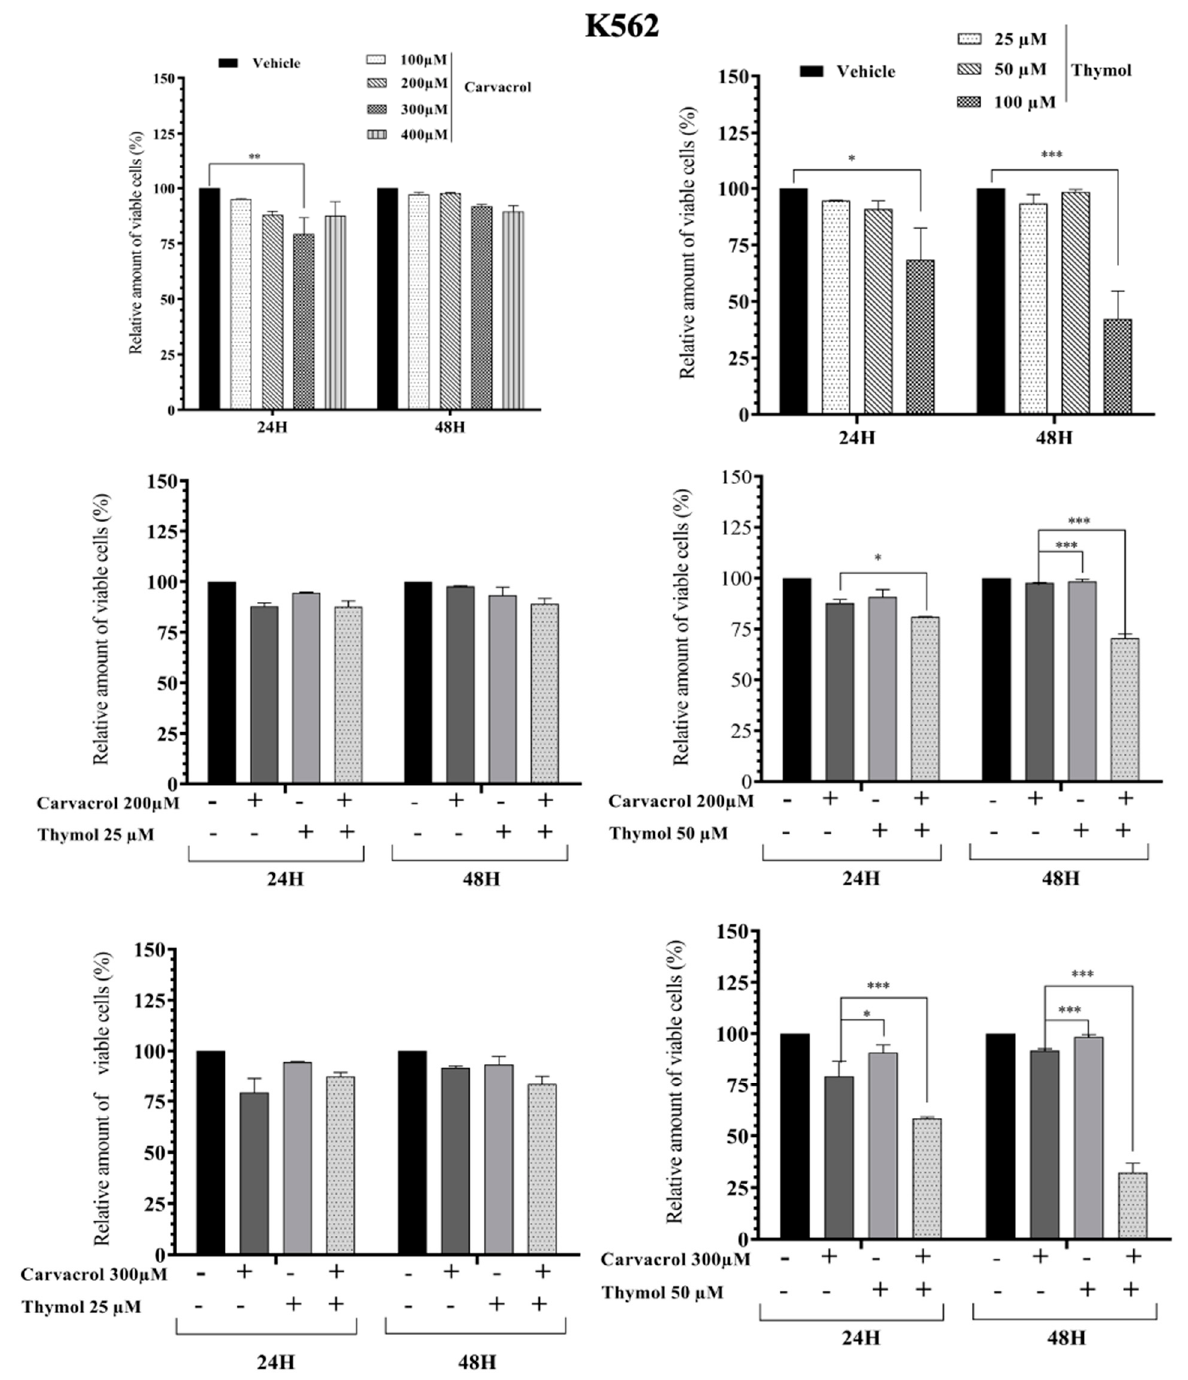
Figure 5. Impact of carvacrol, thymol, and their combination on the viability of the K562 myeloid leukemic cells. Flow cytometric analysis of cell death with AnnexinV-FITC/PI double staining after 24 h and 48 h treatment with different concentrations of carvacrol and thymol (individually or in combination). Data represent the mean ± SEM of three independent experiments relative to vehicle. The levels of statistical significance were set at p < 0.05 (*), p < 0.01 (**) and p < 0.001 (***).